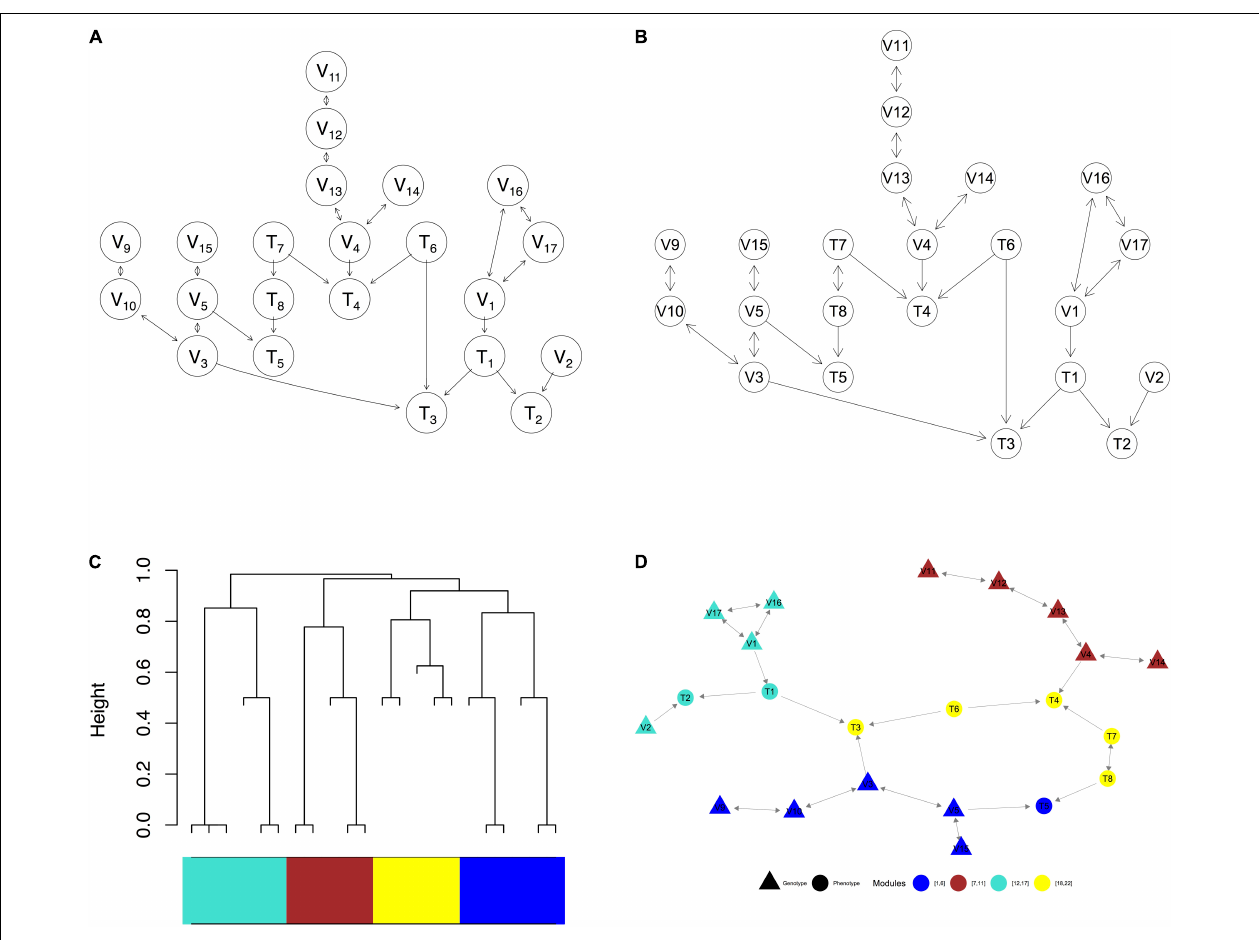
FIGURE 3 | Visualization of a complex graph in MRPC. (A) The true graph includes 14 genetic variants and 8 phenotype nodes. (B) The inferred graph. (C) The dendrogram of the inferred graph with four modules identified when the minimum module size is set to 5. (D) Redrawing the inferred graph based on the dendrogram. Nodes of the same color belong to the same